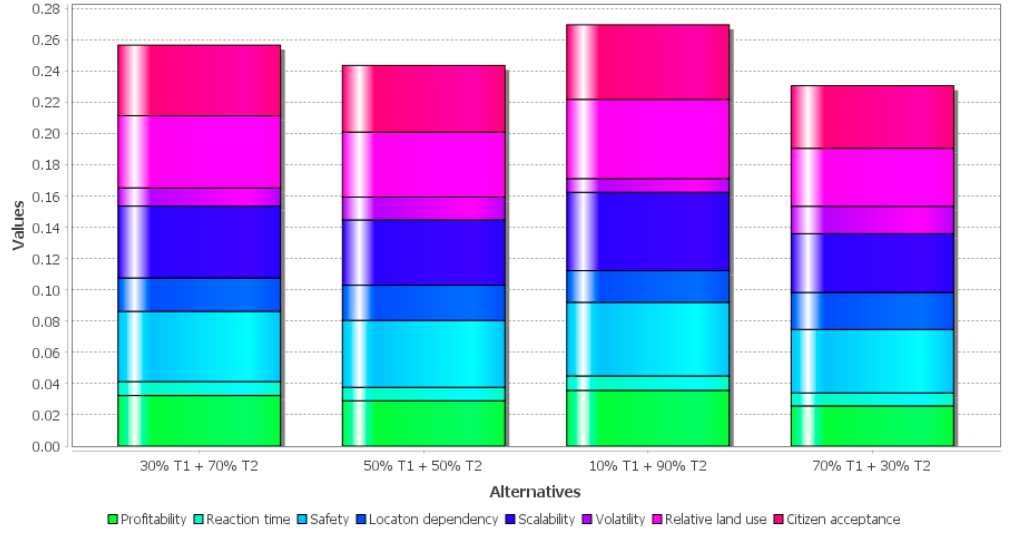
Figure 7. Stacked bar chart of results of the MCDA.